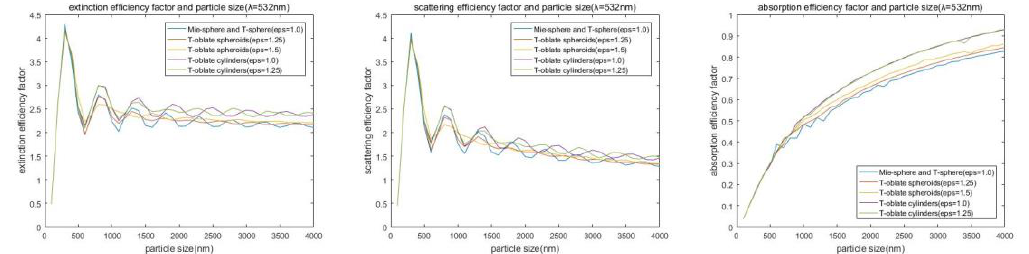
Figure 4. The extinction efficiency factor (left), scattering efficiency factor (middle) and absorption efficiency factor (right) of sphere, oblate sphere and oblate cylinder under the diameter 0 ~ 4um were compared by T-Matrix method and Lorenz-Mie theory(The wavelength was 532nm and the refractive index was